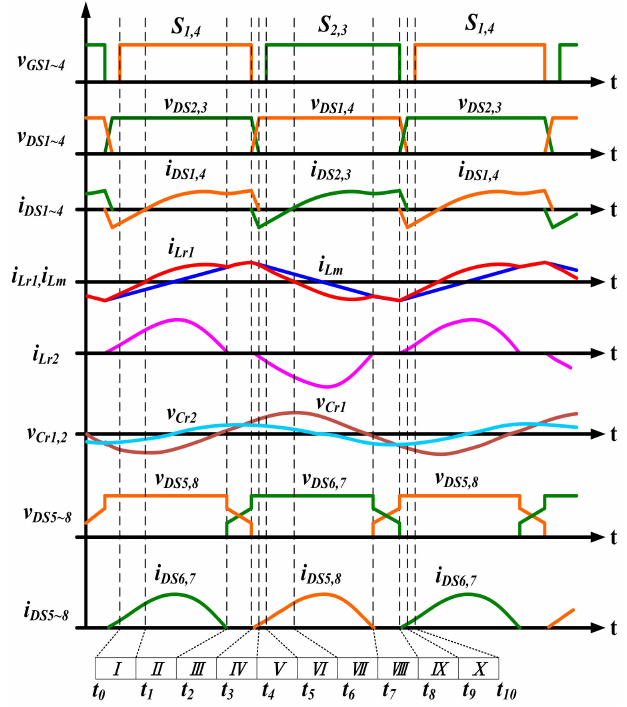
Figure 6. Time series data of the proposed converter when it operates in Region